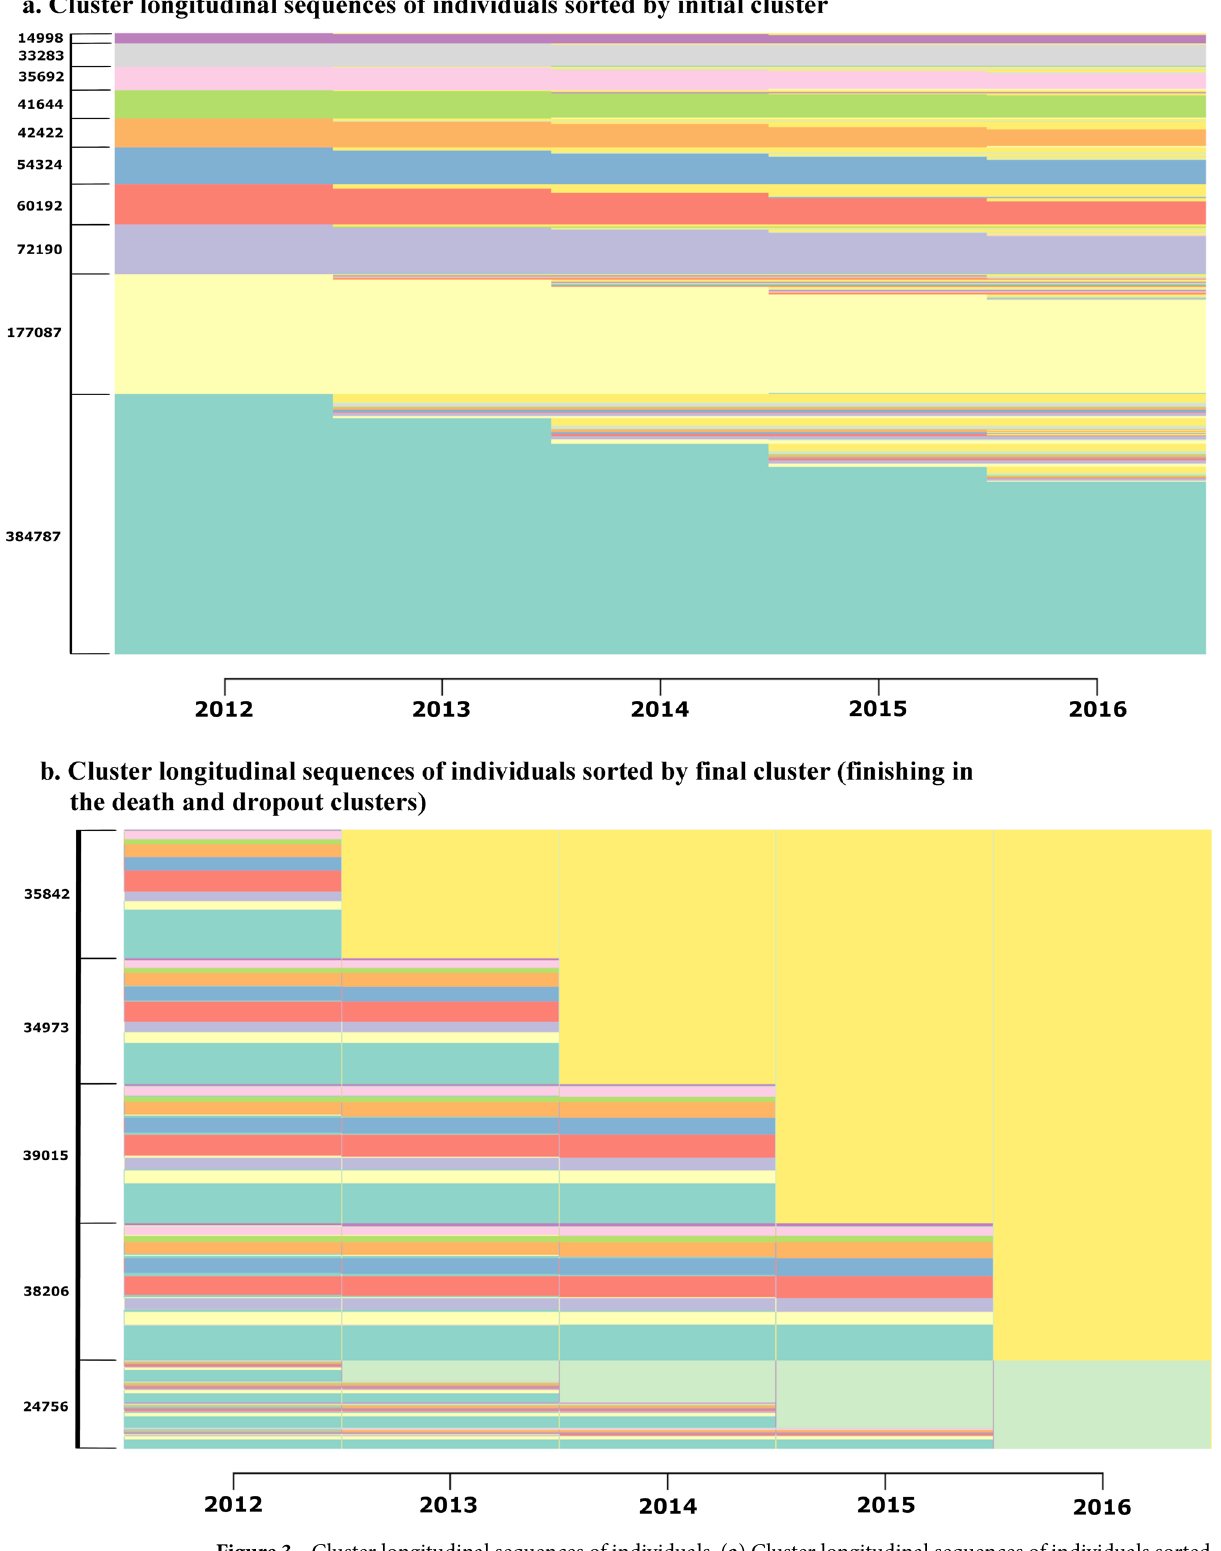
Figure 3. Cluster longitudinal sequences of individuals. ( a ) Cluster longitudinal sequences of individuals sorted by initial cluster. ( b ) Cluster longitudinal sequences of individuals sorted by final cluster (finishing in the death and dropout